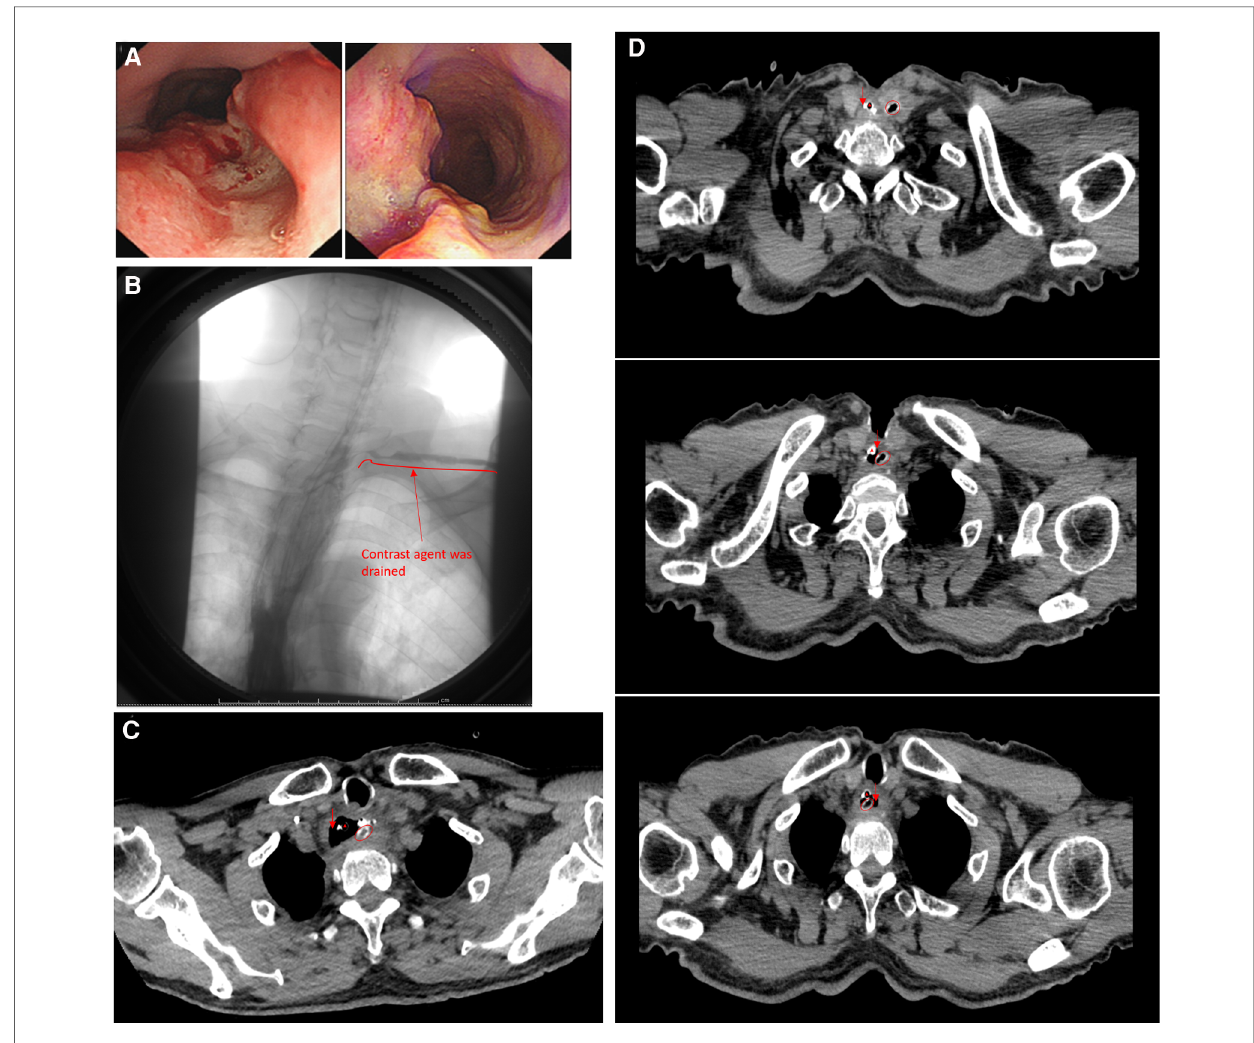
FIGURE 2 ( A ) Preoperative gastroscopic pictures of the patient; ( B ) esophagography on POD 57, contrast agent was drained through the cervical drainage tube; ( C ) CT on POD 8, the cervical drainage clung to the esophageal wall but not penetrate into; ( D ) three slices of CT images on POD 12 showed the extend of the cervical drainage tube from the cervical wound to the esophageal cavity. ○ , cervical drainage tube; ▴ , gastric tube; ↓ , esophageal